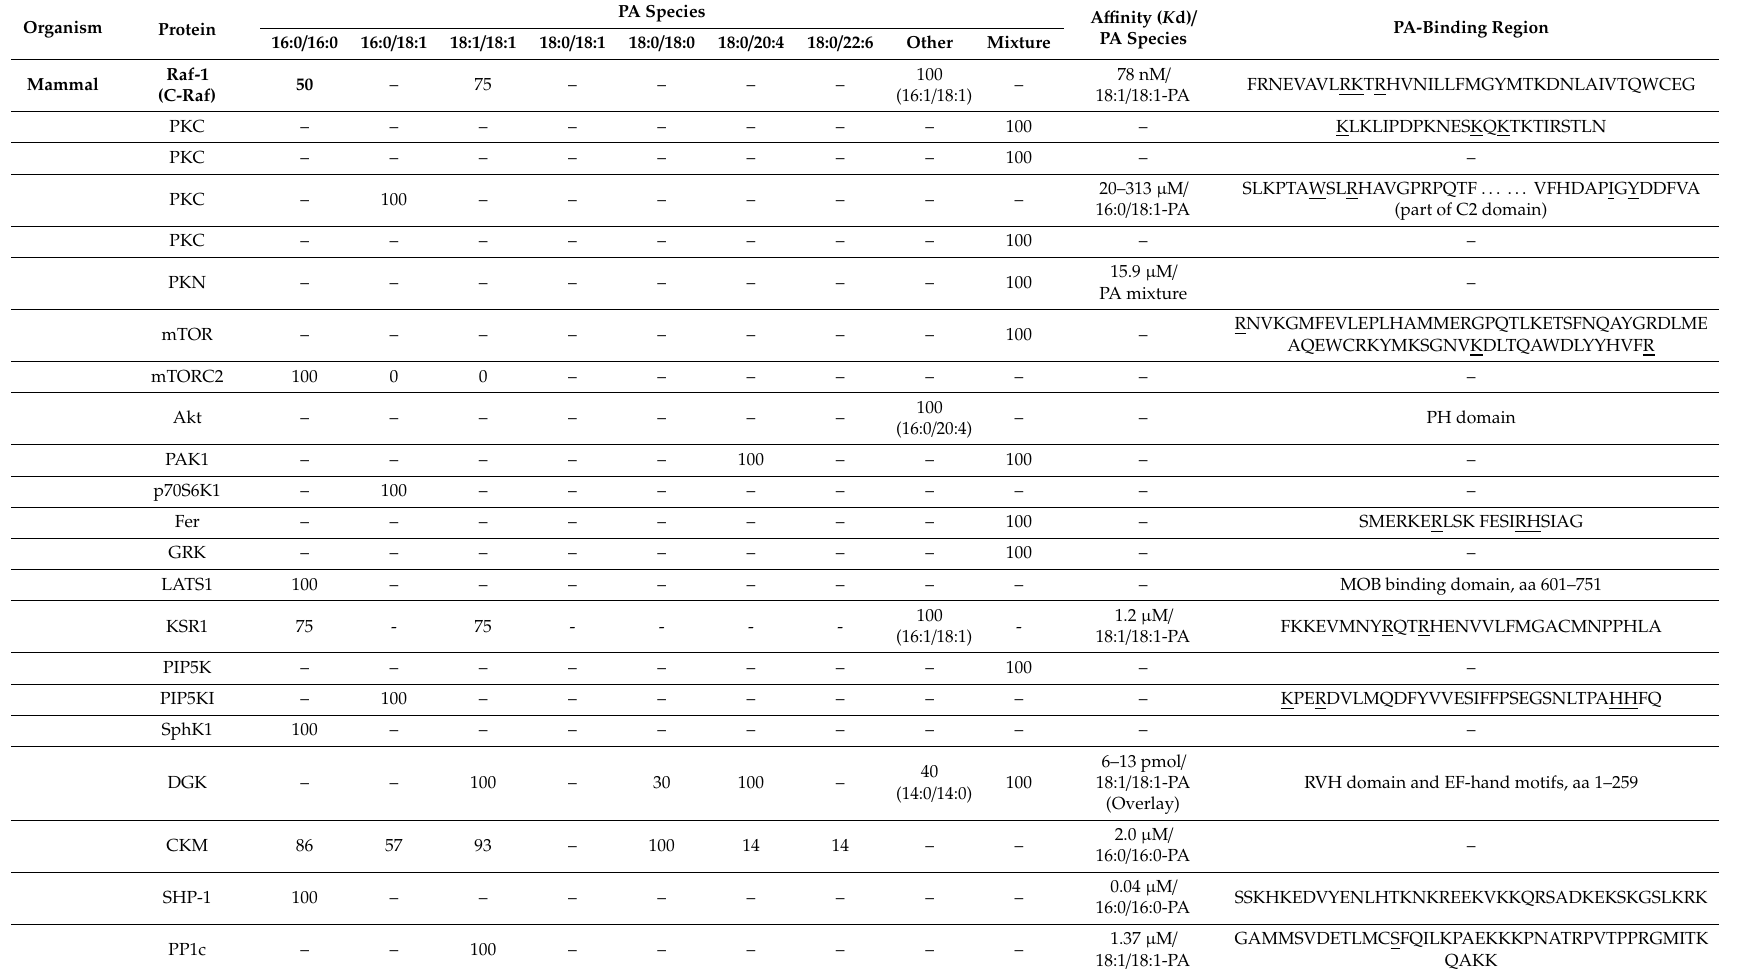
Table 1. PABPs and their PA species